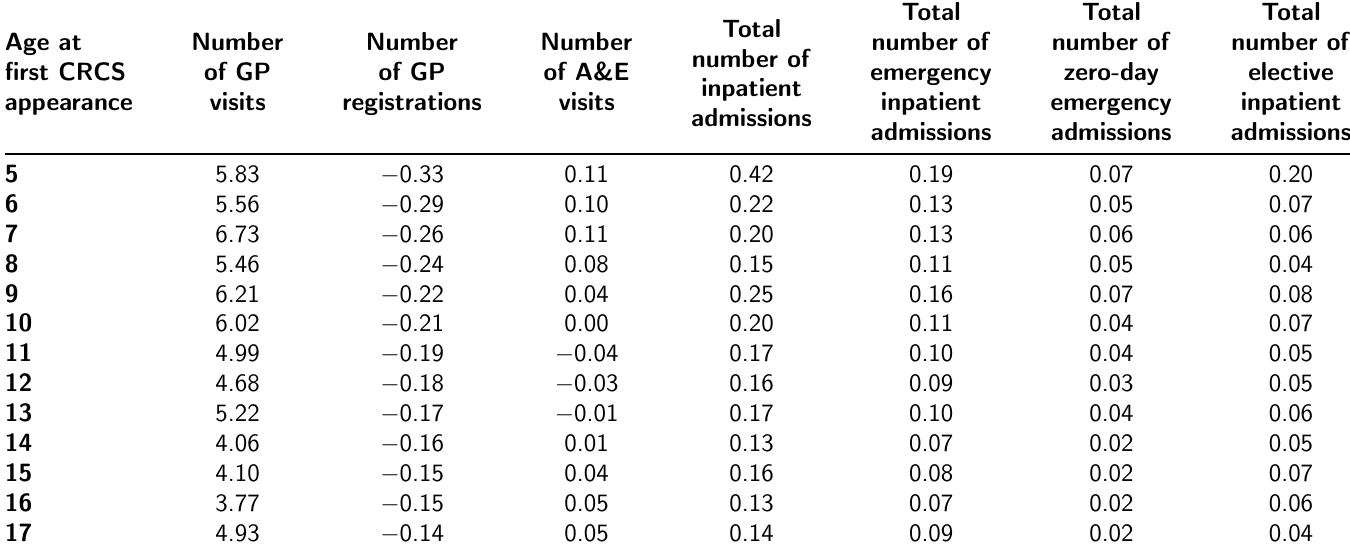
Table 4: Healthcare utilisation rate for children receiving care and support compared to population baseline